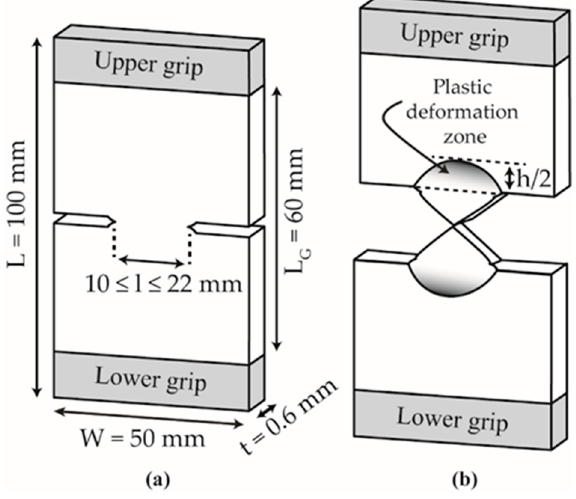
Figure 3. Schematic representation of the DDENT geometry with sample dimensions ( a ) before and ( b ) after testing.